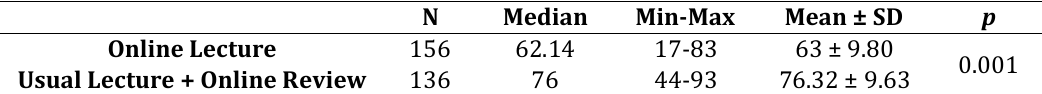
Differences in post-test scores between control and treatment groups